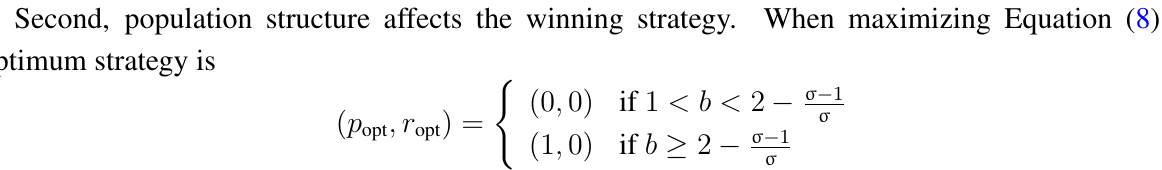
Figure 3. Population structure reduces the density of trustworthy strategies that do not trust and increases the density of trusting and trustworthy ones. Left panel: 1 < b < 2 ( σ 1) σ . The most abundant strategy (green dot) is (0 , 0) – no trust and no trustworthiness. Right ( σ 1) σ . The most abundant strategy (green dot) is (1 , 0) – complete trust panel: b > 2 − − and no trustworthiness. In both panels, compared to well-mixed populations (region under dashed line) population structure selects for fewer trustworthy strategies that do not trust and for more trustworthy strategies that also trust (region under solid